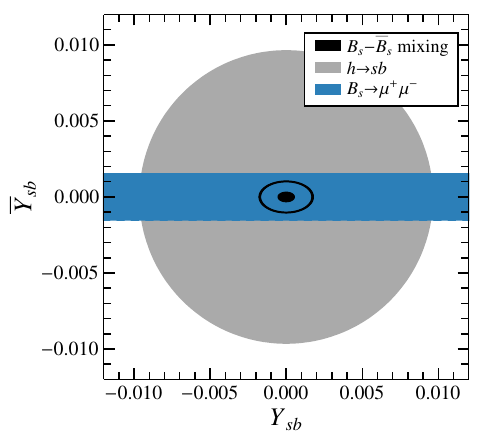
Figure 1 . Allowed region of ( Y sb ; (cid:22) Y sb ) at 95% CL, assuming real Y sb and (cid:22) Y sb couplings. The black region corresponds to the allowed parameter space by B s (cid:0) (cid:22) B s mixing. The blue region is allowed by B ( B s ! (cid:22) + (cid:22) (cid:0) ) with the assumption ( Y (cid:22)(cid:22) ; (cid:22) Y (cid:22)(cid:22) ) = ( Y SM (cid:0)( h ! sb ) < 1 : 4